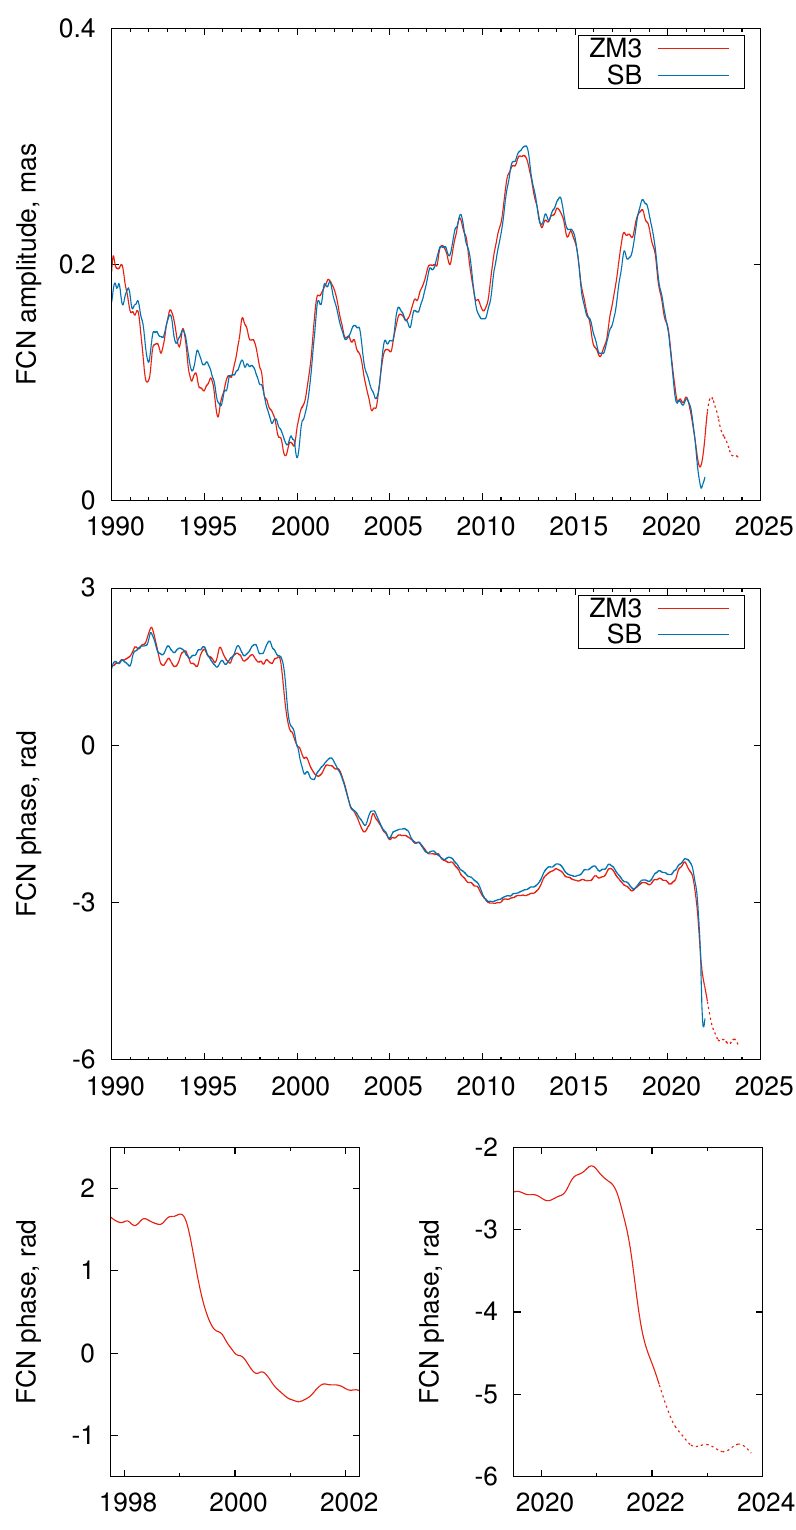
Figure 5. Variations of the FCN amplitude ( upper panel ) and phase ( middle panel ). The bottom zoomed panels show phase variations around two large phase jumps in the same